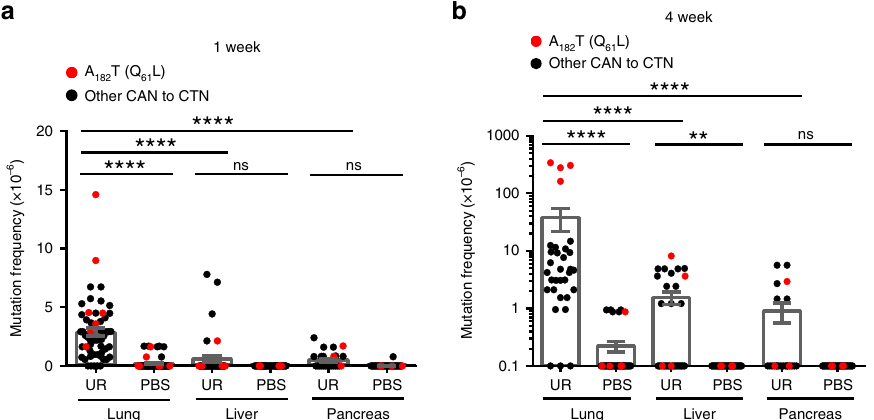
Fig. 4 MDS detects the organ tropism of urethane. a , b Mean ± SEM mutation frequency each possible CAN to CTN transversion determined by MDS for the non-transcribed strand of exon 2 of Kras in the pancreas or liver of mice ( n = 3 mice for pancreas samples from the UR cohort at weeks 1 and 4, 5 mice for liver samples from the UR and PBS cohorts at week 1, and 4 mice for all other cohorts from one experiment) compared with the previous determined mutation frequency in the lung (Fig. 1, n = 7 mice at week 1 and 4 mice at week 4 from one experiment) either ( a ) 1 week or ( b ) 4 weeks after exposure to urethane (UR) or PBS. p values calculated by a Holm-Sidak multiple comparisons test following one-way ANOVA or b Dunn ’ s multiple comparison test following Kruskal – Wallis test. **** p < 0.0001, ** p < 0.01, and ns: not signi fi